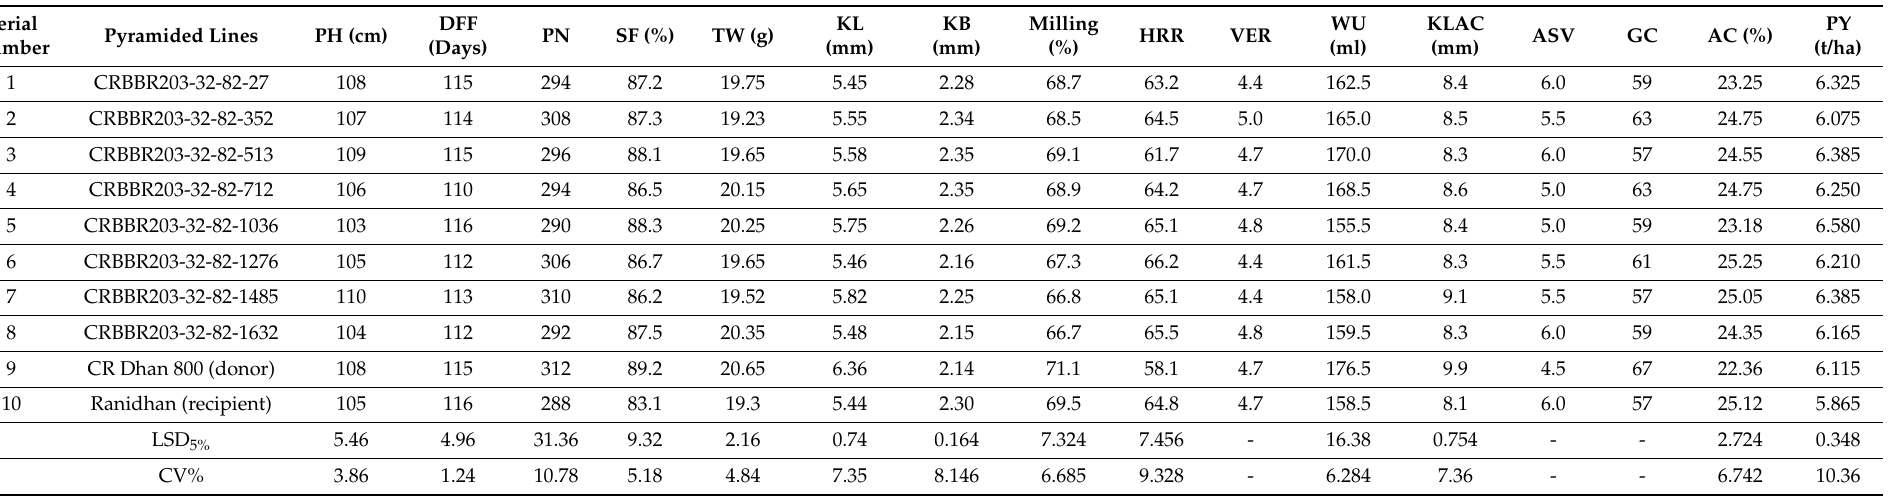
Table 3. Analysis of morphologic and grain quality parameters of BC 3 F 3 and BC 3 F 4 -pyramided and parental rice lines evaluated during wet seasons, 2020 and